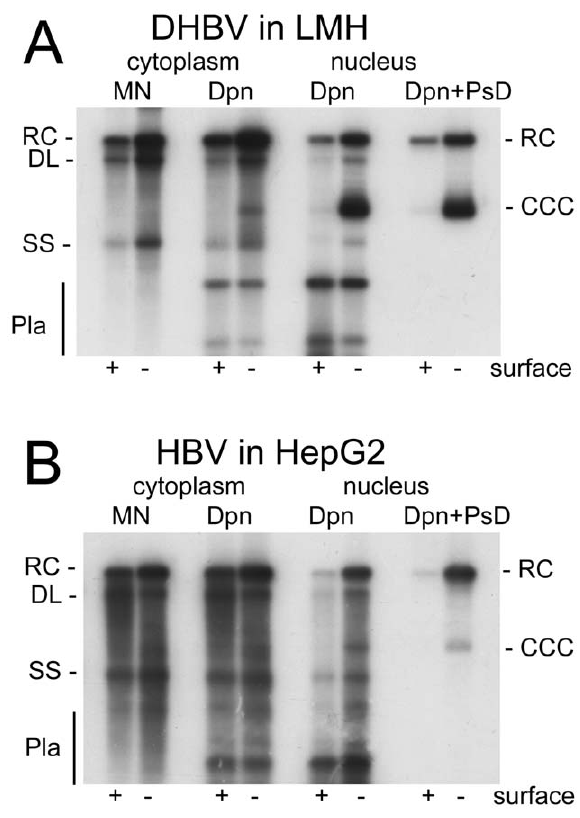
Figure 1. DHBV replication in avian cells and HBV replication in human cells. ( A ) Chicken LMH cells transfected with wild-type and surface-deficient DHBV. ( B ) Human HepG2 cells transfected with wild- type and surface-deficient HBV. DNAs were extracted, after prior PK digestion, from cytoplasmic lysates and the nuclear fractions. One aliquot of the cytoplasmic lysates was treated with micrococcal nuclease (MN) before DNA extraction and analyzed without further treatment. All other samples were incubated, post extraction, with either Dpn I alone (Dpn), or Dpn I plus Plasmid safe DNAse (Dpn + PsD). Nomenclature of the various DNA species: RC, relaxed circular; DL, double strand linear; SS, single strand; CCC, covalently closed circular DNA; Pla, Dpn I restriction fragments of transfected plasmid